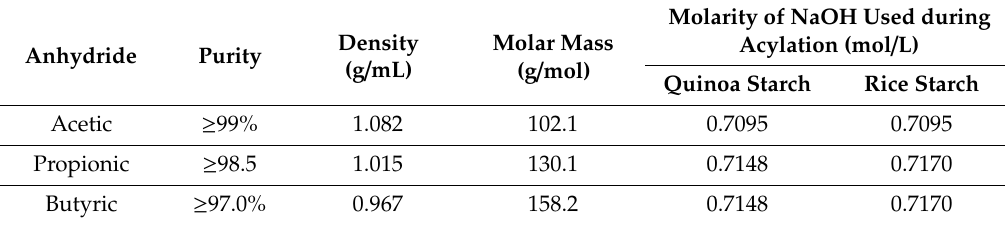
Table 1. Educts for the reaction of short-chain fatty anhydrides with quinoa and rice starch.